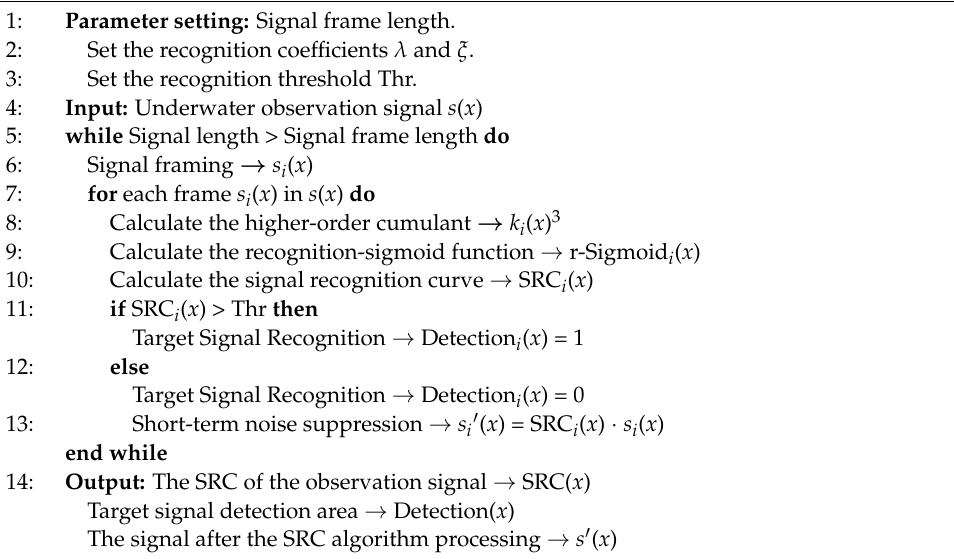
Algorithm 1: The Signal Recognition Curve (SRC)